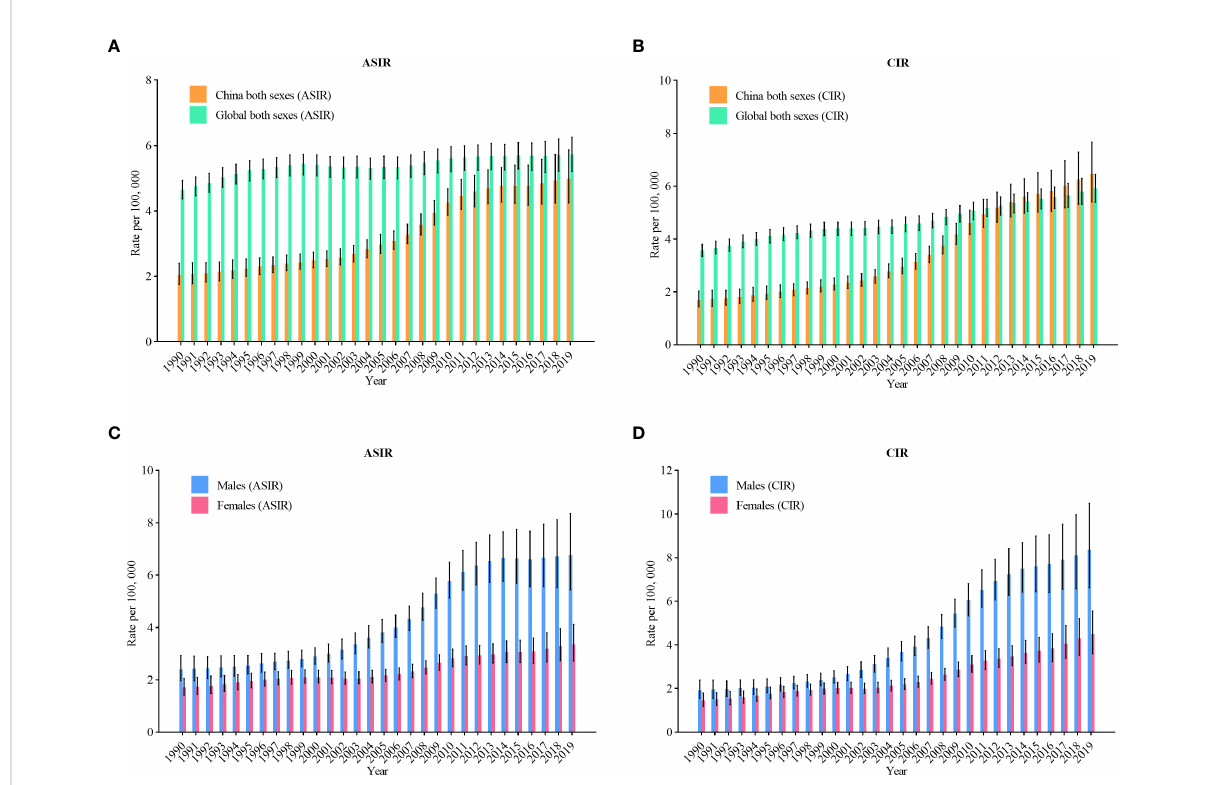
FIGURE 1 Trendsin the age-standardized incidencerates and crude incidence rates(CIR) of non-Hodgkinlymphomain China from1990 to 2019. (A) ASIR for both genders; (B) CIR for both genders; (C) ASIR for males and females; (D) CIR for males and